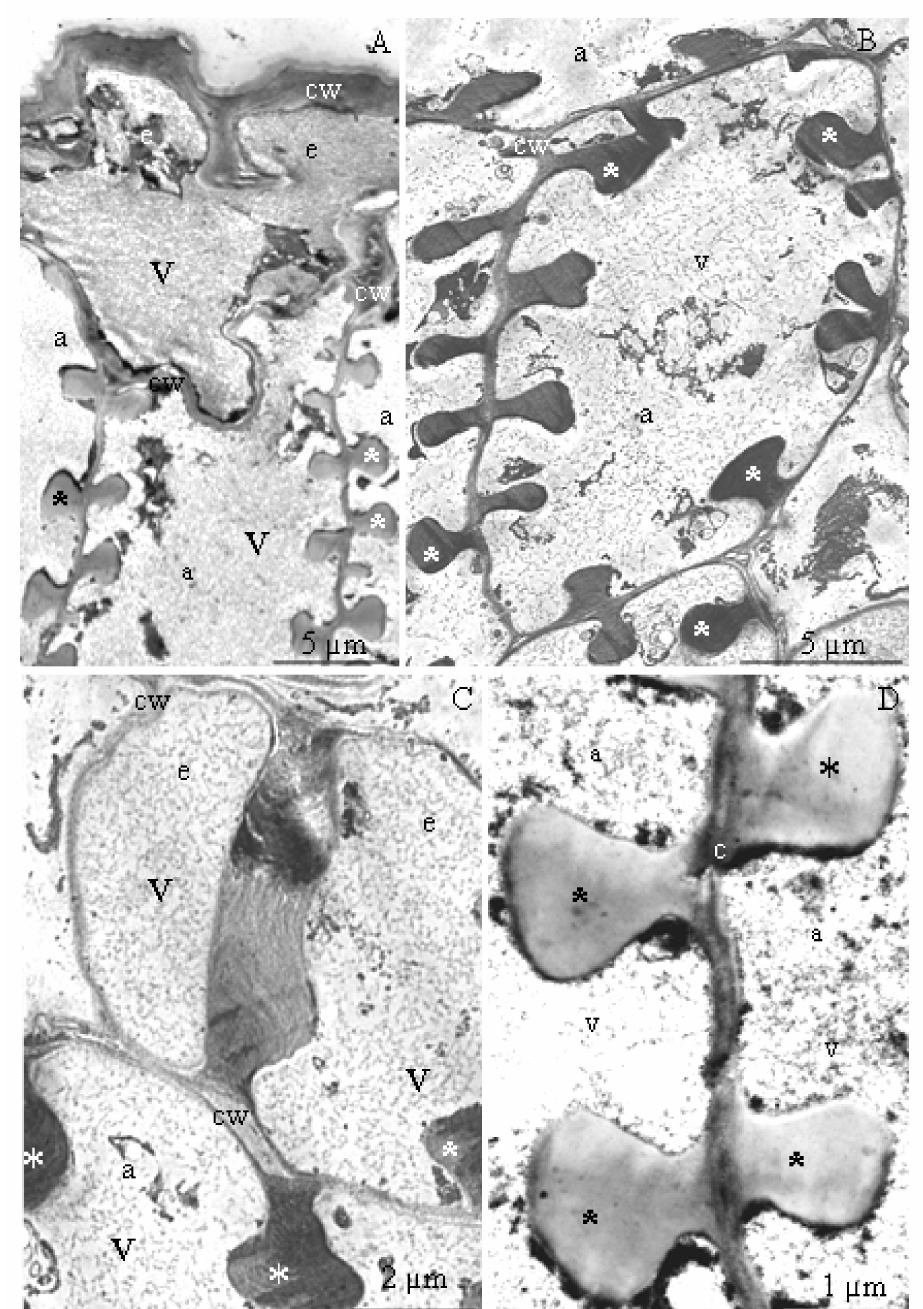
Figure 7. ( A–D ). Epidermis ( A ) and anther endothecium ( A – D ) cells in R. idaeus ‘Glen Ample’ ( A ), ‘Laszka’ ( B ), ‘Polka’ ( C ), ‘Pokusa’ ( D ): ( A )—epidermis (e) and endothecium (a), visible thick outer epidermis cell wall (cw), regular thickenings of the endothecium cell walls (asterisks), vacuole (v), ( B )—endothecium cells, visible anti- and periclinal cell walls (cw) with characteristic thickenings (asterisks), vacuole (v), ( C , D )—epidermis (e) (Figure 7C) and endothecium (a) (Figure 7C,D) cells, visible thickenings (asterisk) of the endothecium cell wall (cw), vacuole (v); ( A – D